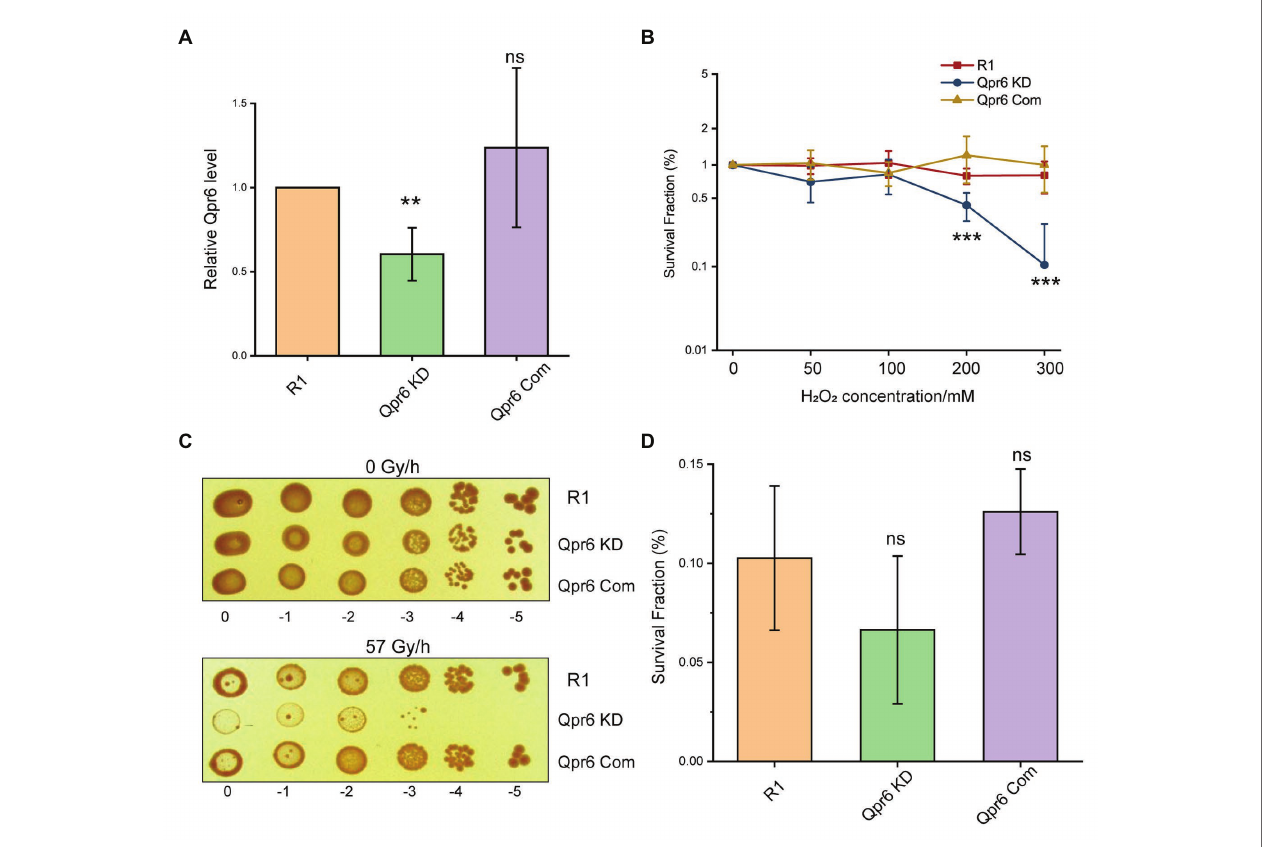
FIGURE 2 | Knockdown (KD) of Qpr6 leads to the hypersensitivity of D. radiodurans to H 2 O 2 and chronic ionizing radiation (CIR). (A) Evaluation of Qpr6 level in R1, Qpr6 KD, and Qpr6 Com by RT-qPCR; (B) Survival of R1, Qpr6 KD, and Qpr6 Com under H 2 O 2 stress; (C) Growth of R1, Qpr6 KD, and Qpr6 Com under 0 and 57 Gy/h radiation ( γ -ray) for 6 days; (D) Survival rate of R1, Qpr6 KD, and Qpr6 Com under 10 kGy ionizing radiation ( β -ray). Error bars indicate standard errors of the means ( n = 3). ** p ≤ 0.01, and *** p ≤ 0.001 were considered as significant using the Student t -test, while ns indicates non-significant compared to R1 ( p >